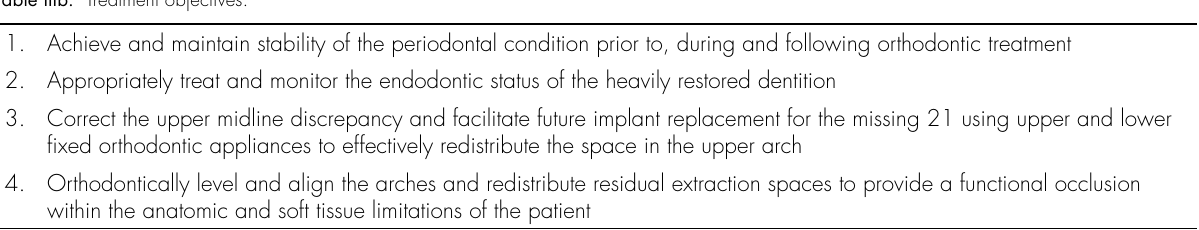
Table IIIb. Treatment